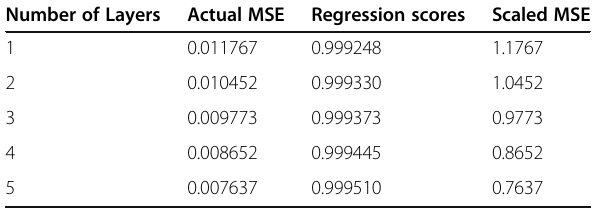
Table 2 Mse and the regression scores for each layer Number of Layers